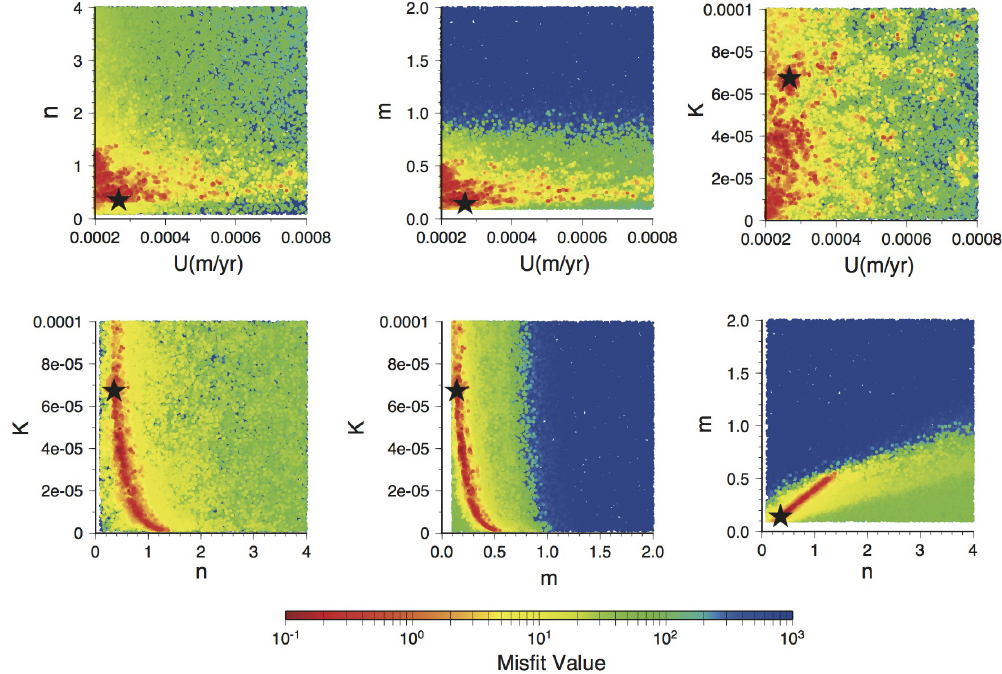
Figure 4. Results from inversion for the free parameters U , K , m and n . Scatter plots showing the results from NA sampling stage.